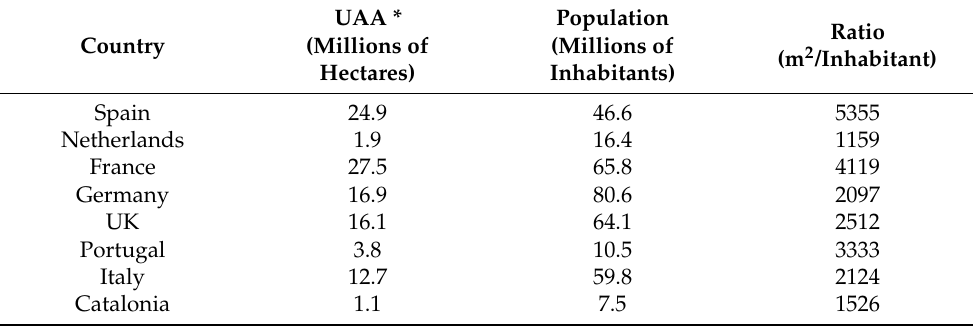
Table 3. UAA* ratio per inhabitant in different European countries. Source: Government of Catalonia (2015); presentation of the draft of the Act on Agricultural Land Use. UAA * Population Country (Millions of (Millions Hectares)